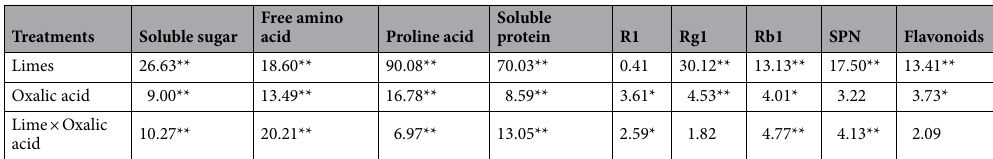
Table 5. Variance analysis of the effects of oxalic acid, calcium and cadmium on the contents of multiple medicinal ingredients in the roots of Panax notoginseng (F